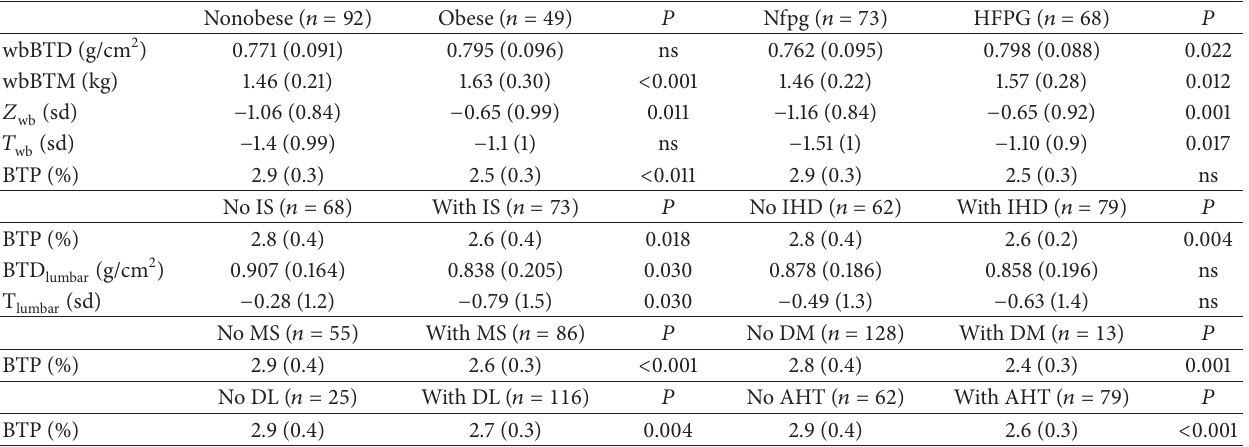
Table 5: wbDXA bone indices according to cardiovascular morbidity ( 𝑛 = 141